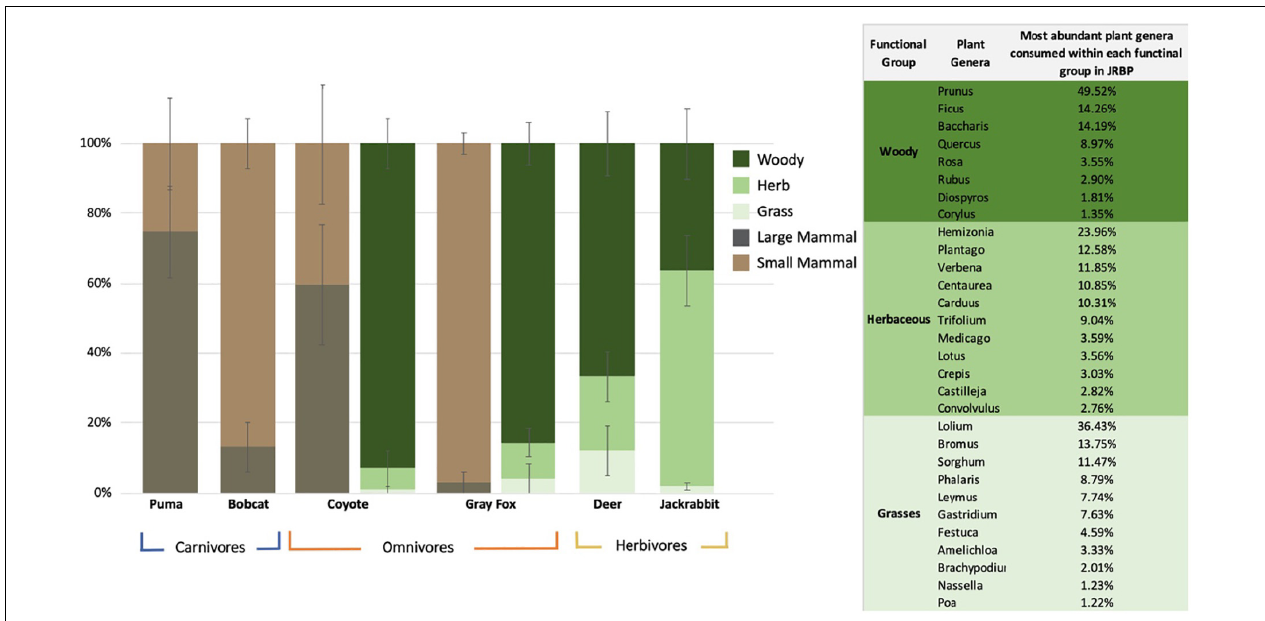
FIGURE 1 | Mean percentage ± SE of the relative read abundance per species per diet functional groups. The two omnivores (coyote and gray fox) have two columns representing both their plant and animal diets. The panel represents the percent of total plant genera reads identified in the diets of herbivore and omnivores within JRBP, showing only genera that comprised 1% or more of the diet. TABLE 3 | Diet composition of six focal species, described at the functional groups of plants and mammals consumed and expressed by the Count, FOO, POO, and RRA. Functional